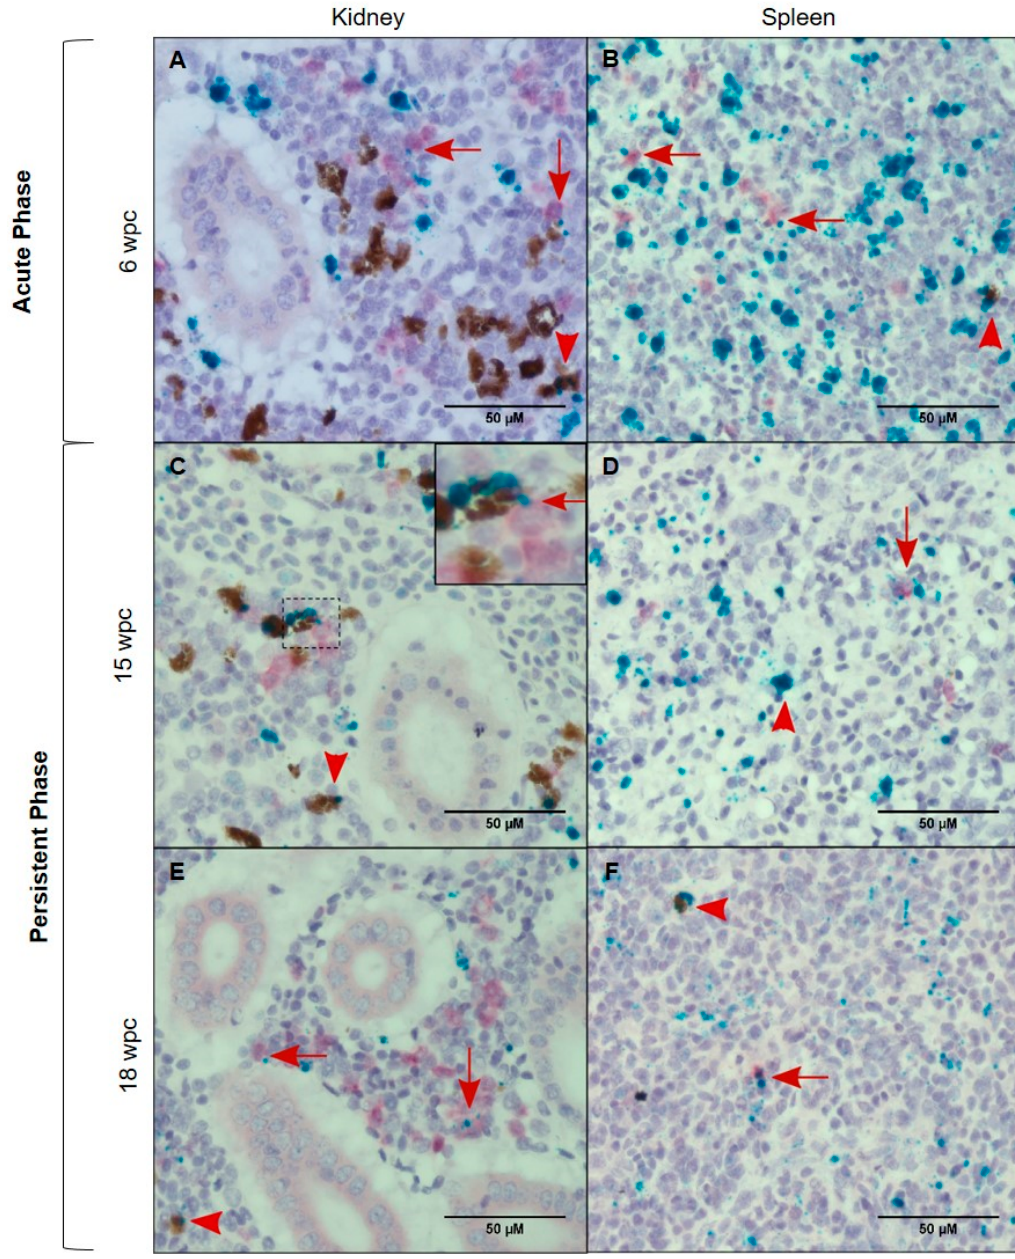
Figure 6. PRV-1 (green) localization in macrophages and melano-macrophages. Duplex in situ hybridization against PRV-1 and macrophage colony stimulating factor (MCSFR) (red). Kidney ( A , C , E ) and Spleen ( B , D , F ), showing PRV positive macrophages (red arrows) and melano-macrophages (red arrowhead) at 6 wpc, 15 wpc and 18 wpc. The use of red dye in salmon kidney sections in duplex in situ gave di ff use staining of positive cells (no background staining). The di ff use staining was di ff erent from the punctate staining seen in single in situ , or the use of green dye in duplex in situ. PRV-1 is also positive in other cell types in the sections. Scale bar = 50 µ